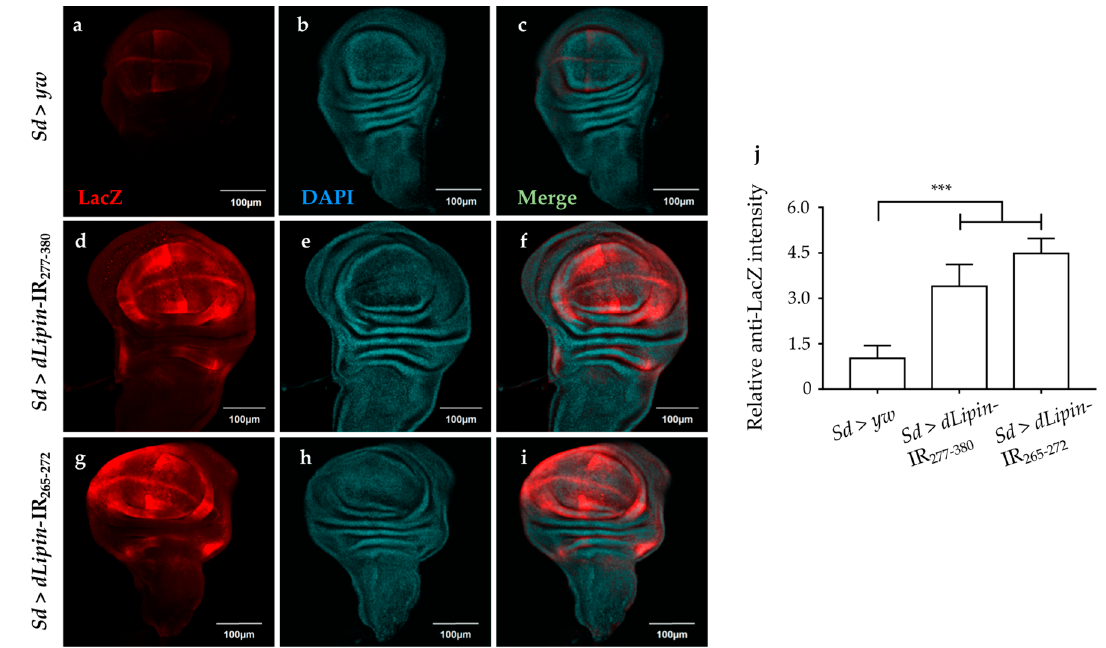
Figure 8. Knockdown of dLipin activates the pro-apoptotic gene reaper . Wing imaginal discs from the 3rd-instar larvae of control and dLipin -kd flies that carry rpr -lacZ were stained with an anti-lacZ antibody ( a, d, g ) and with DAPI ( b, e, h ). Both images were merged ( c, f, i ). The fluorescence intensities in the wing pouch stained with anti-lacZ were analyzed using MetaMorph software ( n = 14 for each genotype) ( j ). Data are expressed as the means ± S.D. The statistical significance of the difference between control and dLipin -kd flies was evaluated using one-way ANOVA. ***, p < 0.01; Scale bar, 100 µm; IR, inverted repeat. Genotypes: Sd -GAL4/+; +; rpr -lacZ/+ ( a – c ), Sd -GAL4/+; UAS - dLipin- IR 277-380 /+; rpr -lacZ/+ ( d – f ), Sd -GAL4/+; UAS -dLipin- IR 254-476 /+; rpr -lacZ/+ ( g – i ).